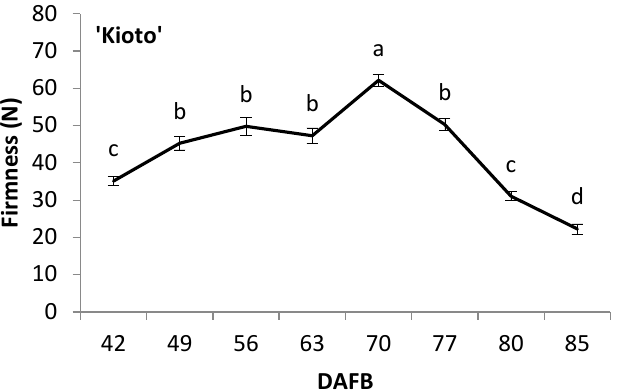
Figure 4. Evolution of apricot fruit firmness during its development and ripening on the tree. The letters represent significant differences according to Tukey’s test at a level of p < 0.05. Mean values ± standard error (n = 20).